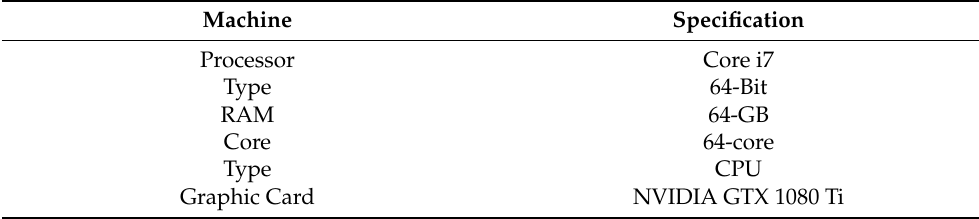
Table 3. Hardware